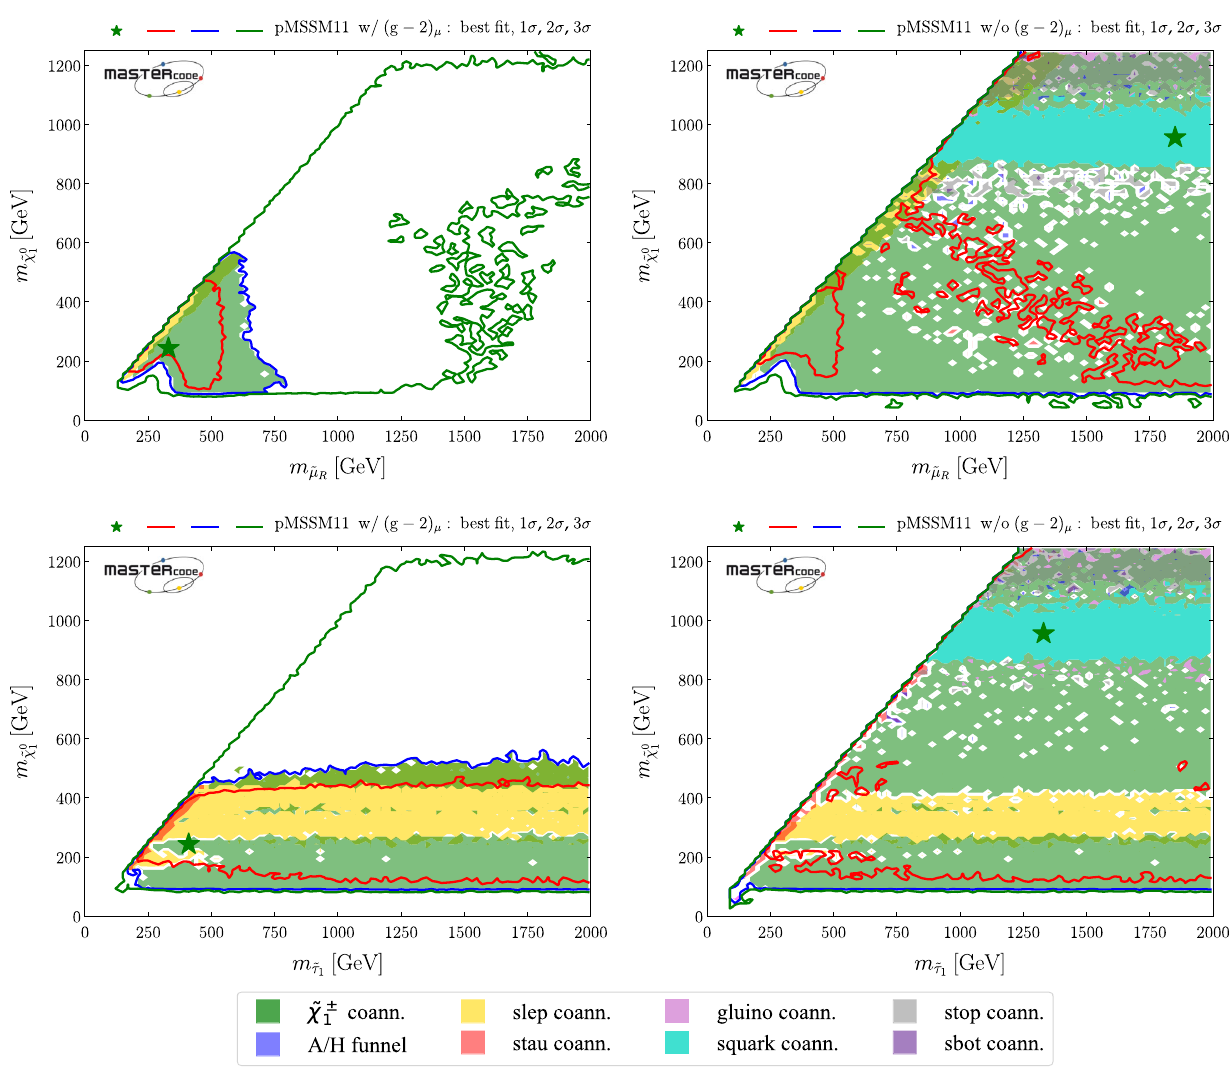
, m ) planes(upperpanels)andthe ( m ˜ τ ˜ χ 0 R 1